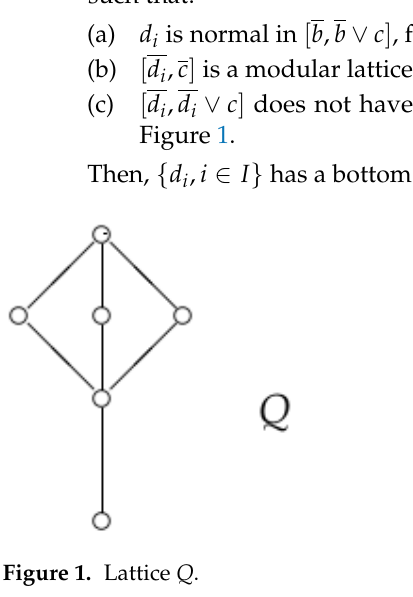
Figure 1. Lattice Q